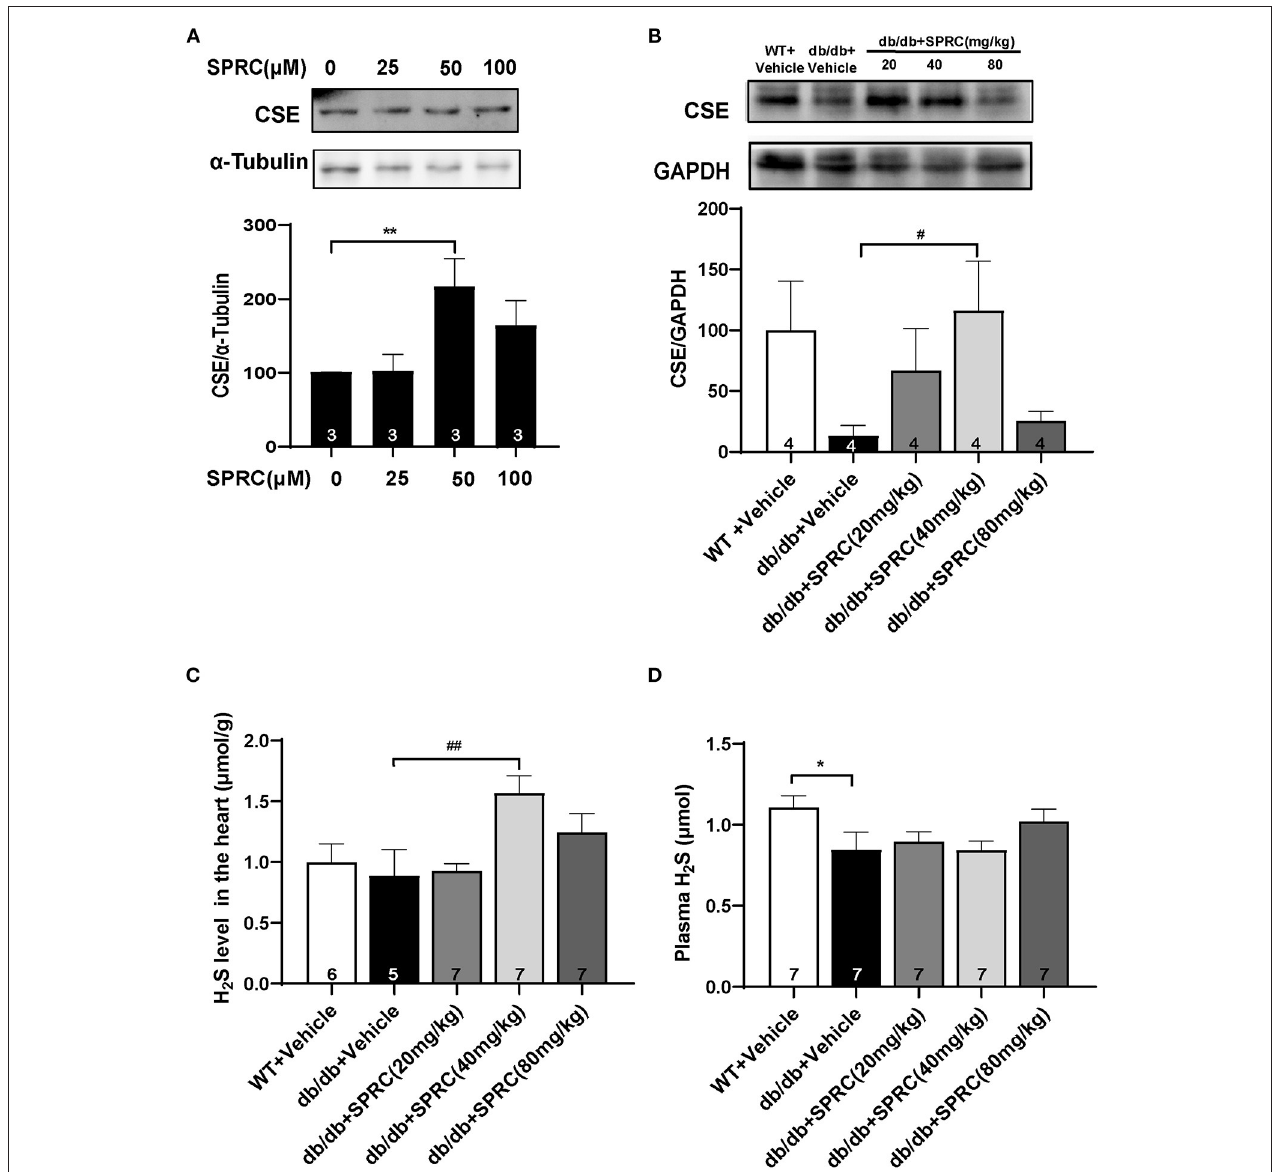
FIGURE 9 | SPRC treatment increased CSE expression and H 2 S content in the myocardium. (A) Primary mice cardiomyocytes were treated with vehicle or SPRC (25, 50, and 100 µ M) for 24h. The expression level of CSE were determined by western blotting ( n = 3). ** P < 0.01 vs. Vehicle group. (B–D) Vehicle or SPRC (20, 40, or 80 mg/kg/day) was orally administered to WT mice or db/db mice for 12 weeks. The expression level of CSE were determined by western blotting ( n = 4), H 2 S levels in the myocardium ( n = 5–7), and plasma ( n = 7) were detected. * P < 0.05, ** P < 0.01 vs. WT + Vehicle group, # P < 0.05, ## P < 0.01 vs. db/db + Vehicle mice. Values are presented as means ±